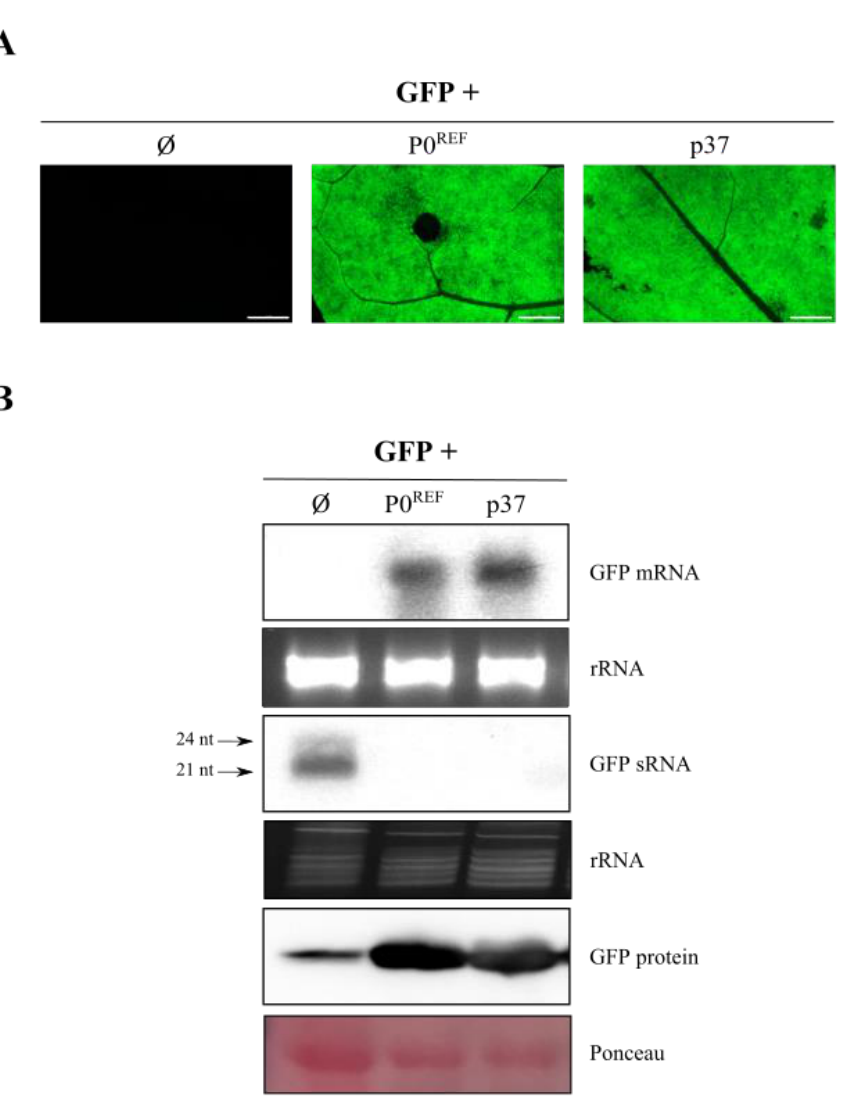
Figure 1. Assessment of RNA silencing suppressor activity of PeVYV-5 P0. N. benthamiana leaves were agroinfiltrated with constructs for expression of GFP either alone (Ø) or in combination with constructs directing expression of PeVYV-5 P0 REF or PLPV p37. ( A ) GFP fluorescence at 10 dpif in infiltrated leaf patches. The inset scale bar corresponds to 5 mm in all panels. ( B ) Northern blot hybridization and Western blot analysis for detection of the GFP mRNA (upper panel), derived sRNAs (middle panel) or GFP protein (lower panel) in infiltrated tissues harvested at 10 dpif. Ethidium bromide staining of RNA is shown as loading control below Northern blot panels. Ponceau S staining is shown below Western results as loading control.